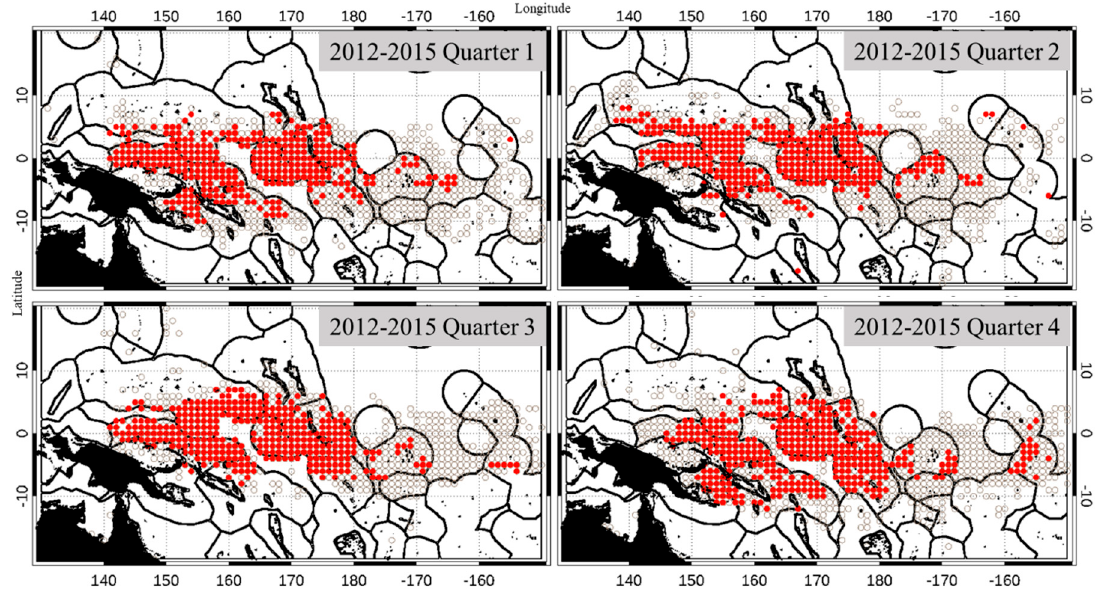
Figure 4. Quarterly distributions of 1° × 1° grid (global datasets: Gray circles; Taiwanese datasets: Red dot) during the years 2012–2015. Black contour lines are exclusive economic zones.